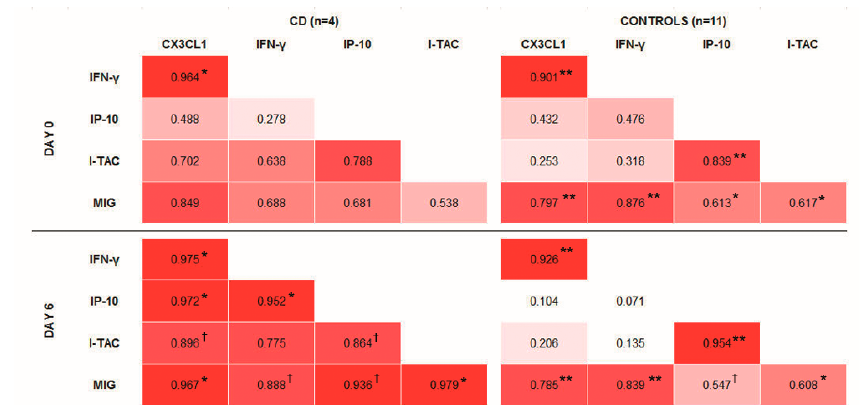
Figure 1. Bivariate correlations between the soluble markers studied. Pearson´s coefficient has been used to establish a colour scale, because p -values vary depending on the sample size. † p ≤ 0.1; * p < 0.05; ** p < 0.01.